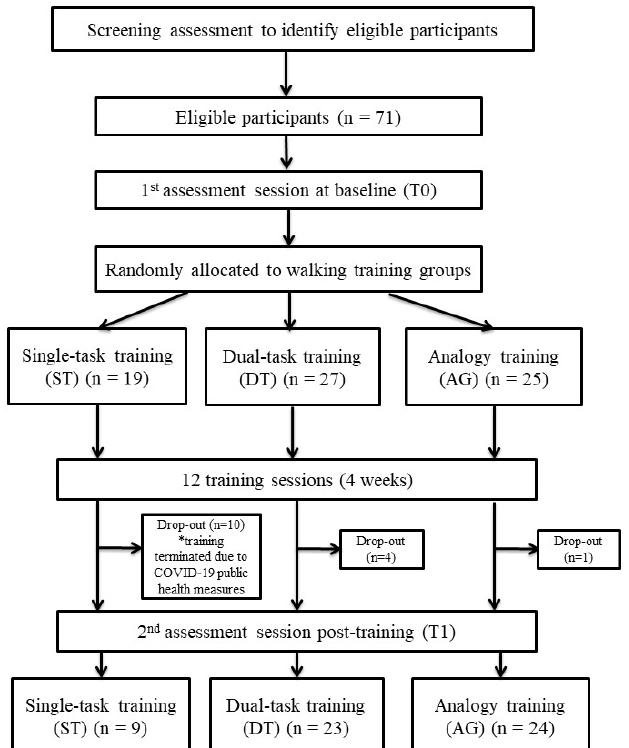
Figure 1. Schematic diagram of the study flow. * Training was terminated due to COVID-19, leading to a high drop-out in ST group.